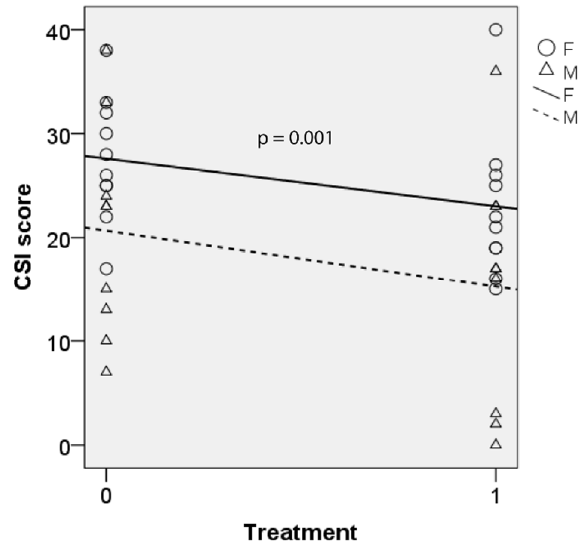
Figure 4. CSI scores before and after BTX therapy with linear trend lines for male (M) and female (F). Lower score indicates better outcome. 0 = baseline; 1 = post-BTX treatment. Lower score indicates better outcome. 0 = baseline; 1 = post-BTX treatment.